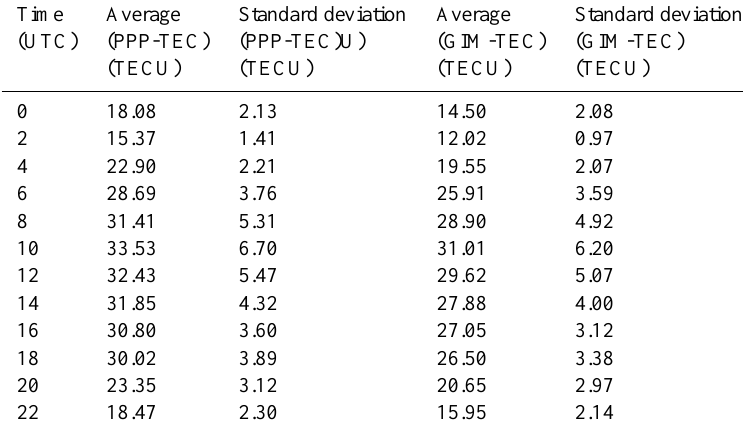
Table 5. YENC station 2h resolution average TEC